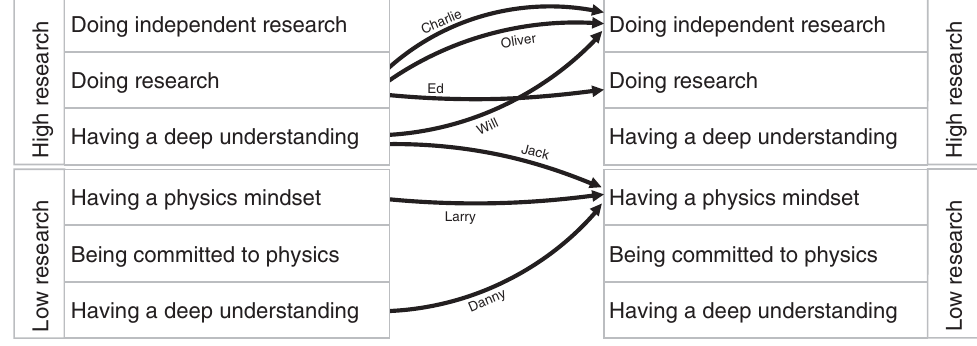
FIG. 2. Transitions of students between